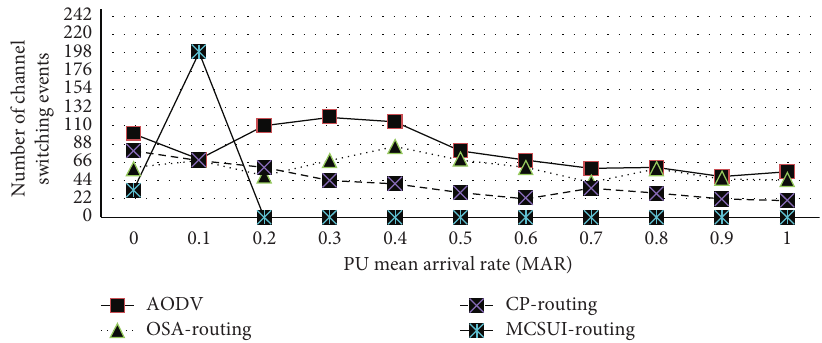
Figure 12: Channel switching events of SU at PU’s sd of MAR as 0.0